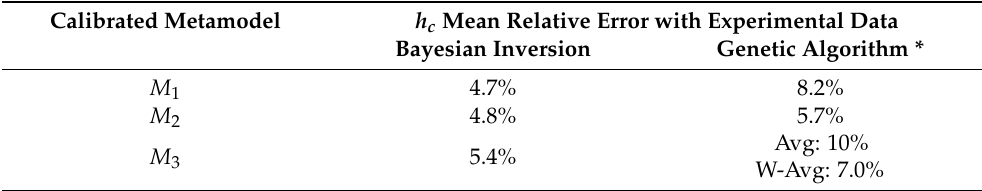
Table 9. Errors with experimental data for each calibration.